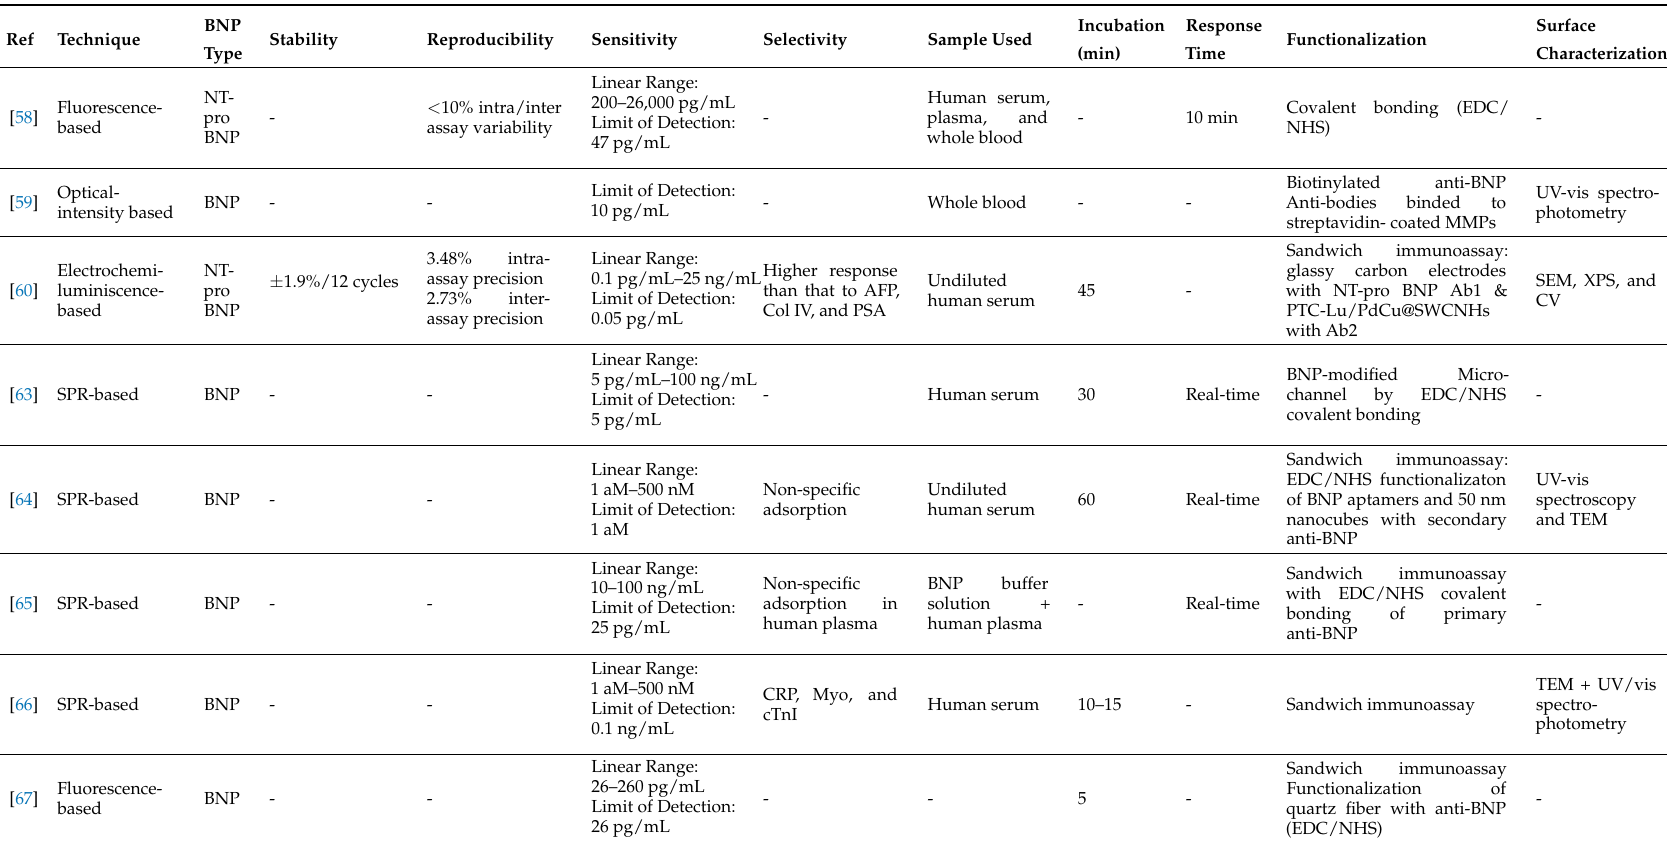
Table 2. Review of optical and electrochemical biosensors for BNP